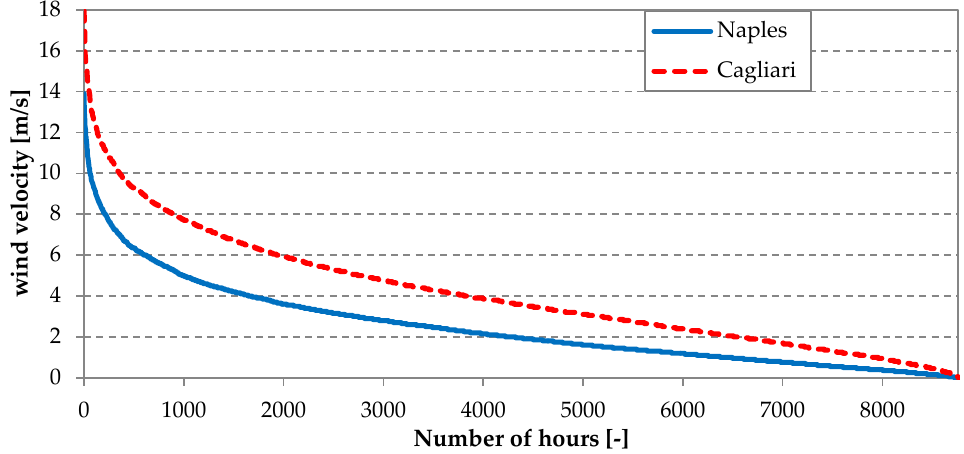
Figure 7. Duration curve of the wind speed.